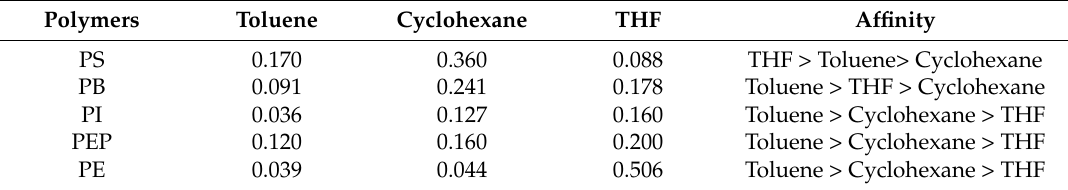
Table 2. Characteristic results for the Flory–Huggins χ sp parameter between used solvents and polymeric blocks, together with the affinity of each block for all